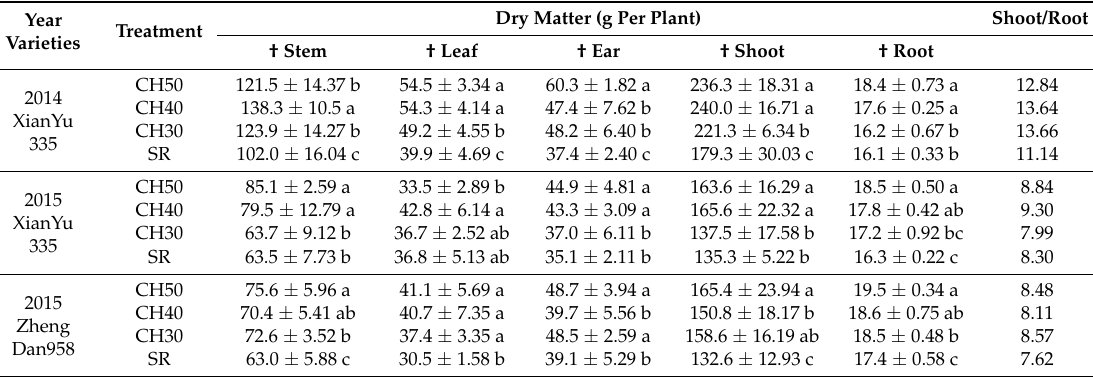
Table 5. Dry matter distribution in different organs and shoot root ratio in maize at the silking stage as affected by tillage treatment. Values are the mean of three replications ± 1 standard error.